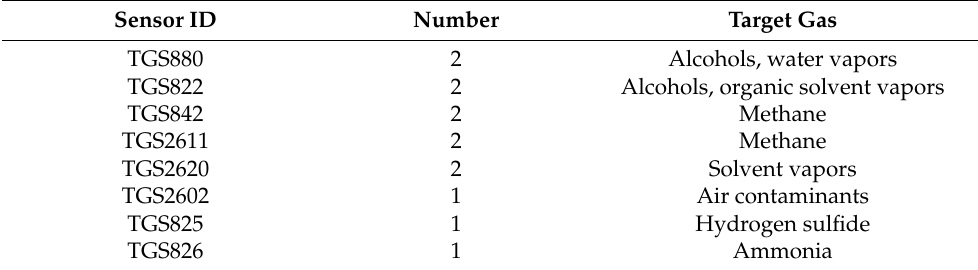
Table 3. Array of metal-oxide semiconductor gas sensors (MOS) present in the IOMS